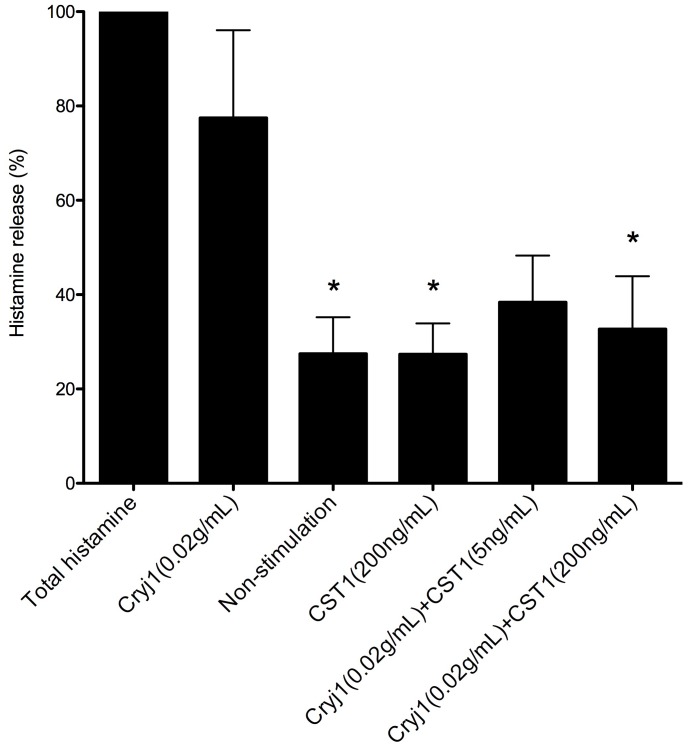
Histamine release by peripheral basophils stimulated with JC allergen.Cells were cultured with Cryj1 both in the presence and absence of recombinant CST1. *, P<0.05.